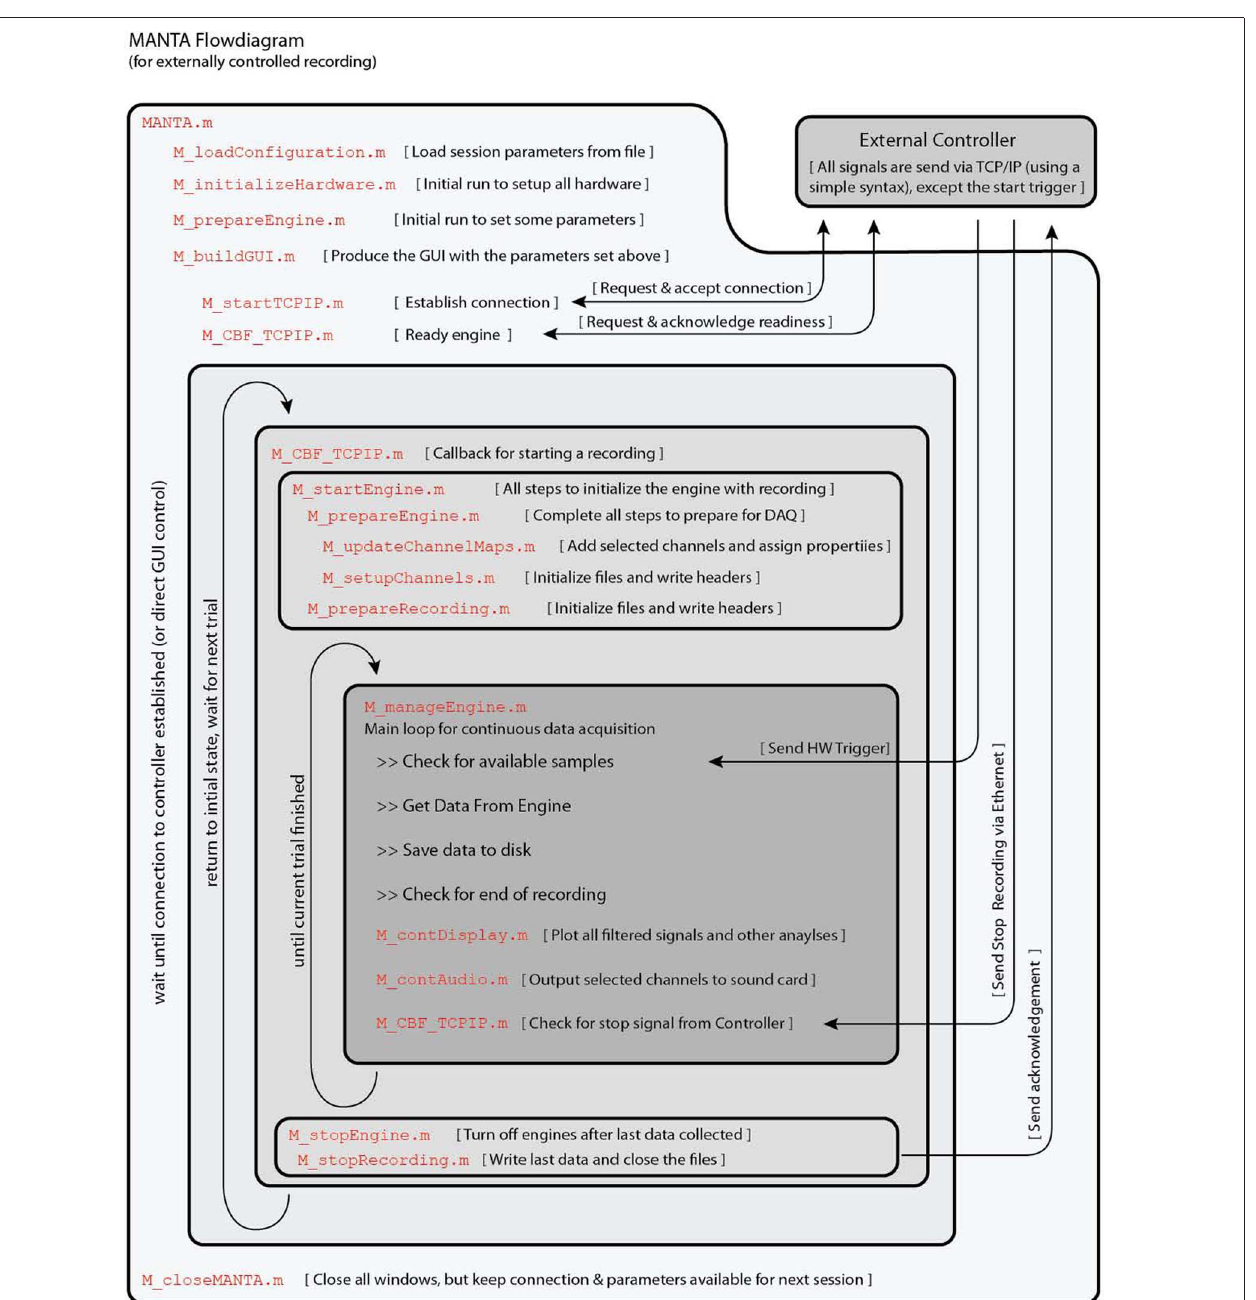
FIGURE A1 | Flow diagram of